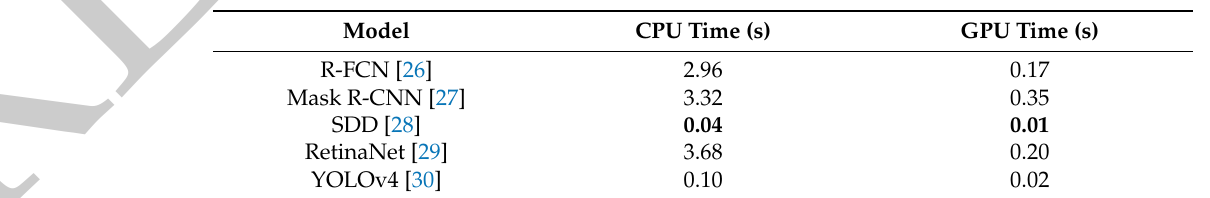
Table 6. The computation time of object detection models on the BDD100K